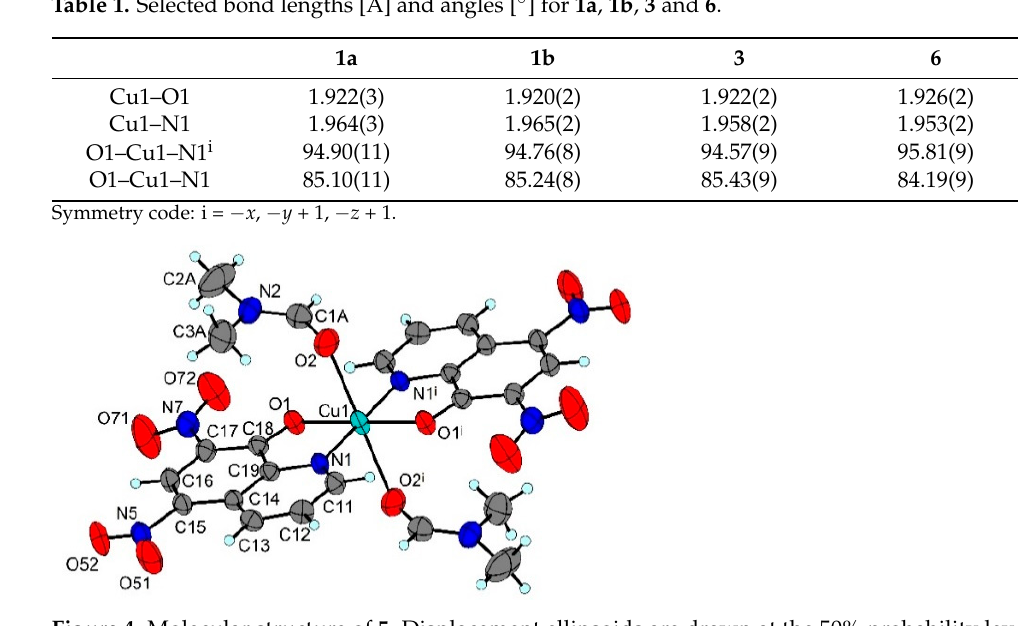
Figure 3. Molecular structure of 1b , 3 and 6 (left to right). Displacement ellipsoids are drawn at the